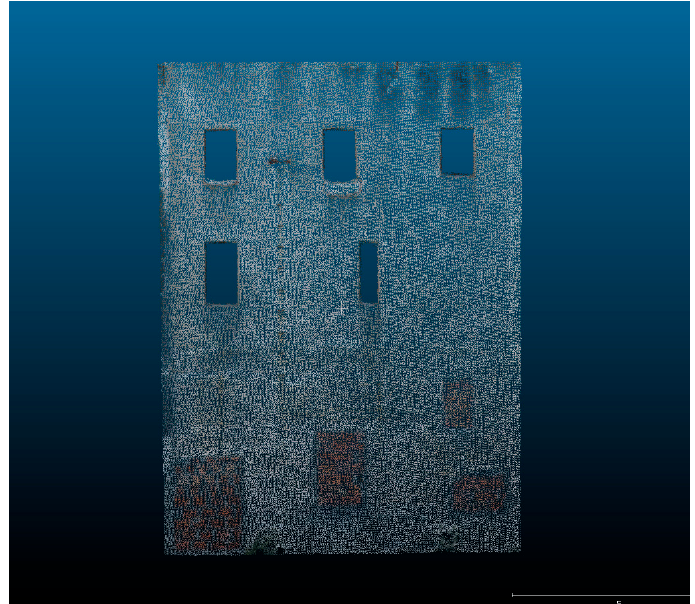
Figure 24. UAV Nadir + Oblique in Pix4D. Table 13. Statistical values of the comparisons between the TLS data and the point clouds.